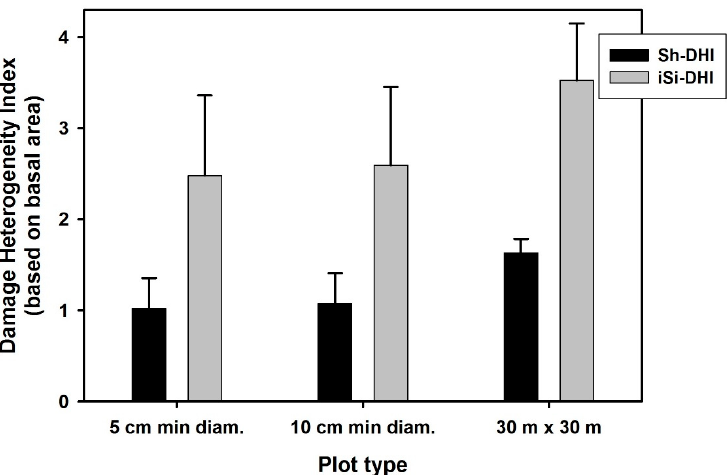
Figure 3. Mean and standard deviation of two damage heterogeneity indices, for three types of sampling plots. Each plot’s damage heterogeneity was calculated using the basal area in each damage category as the abundance values input into the diversity formula. The ‘5 cm minimum diameter and ‘10 cm minimum diameter’ plot types were all 20 m × 20 m plots, while the ‘30 m × 30 m’ plot type had a 5 cm diameter minimum.